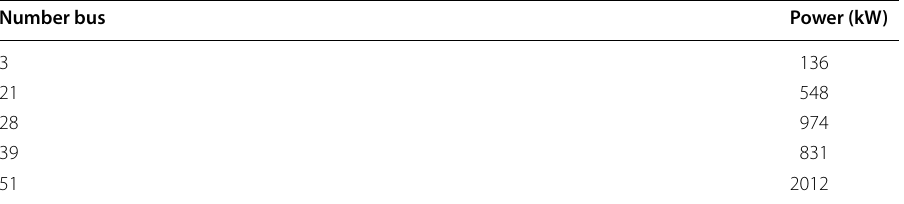
Table 6 Parameters of placement and sizing under the output power factor of 0.85 pre-phase in the 69-bus network